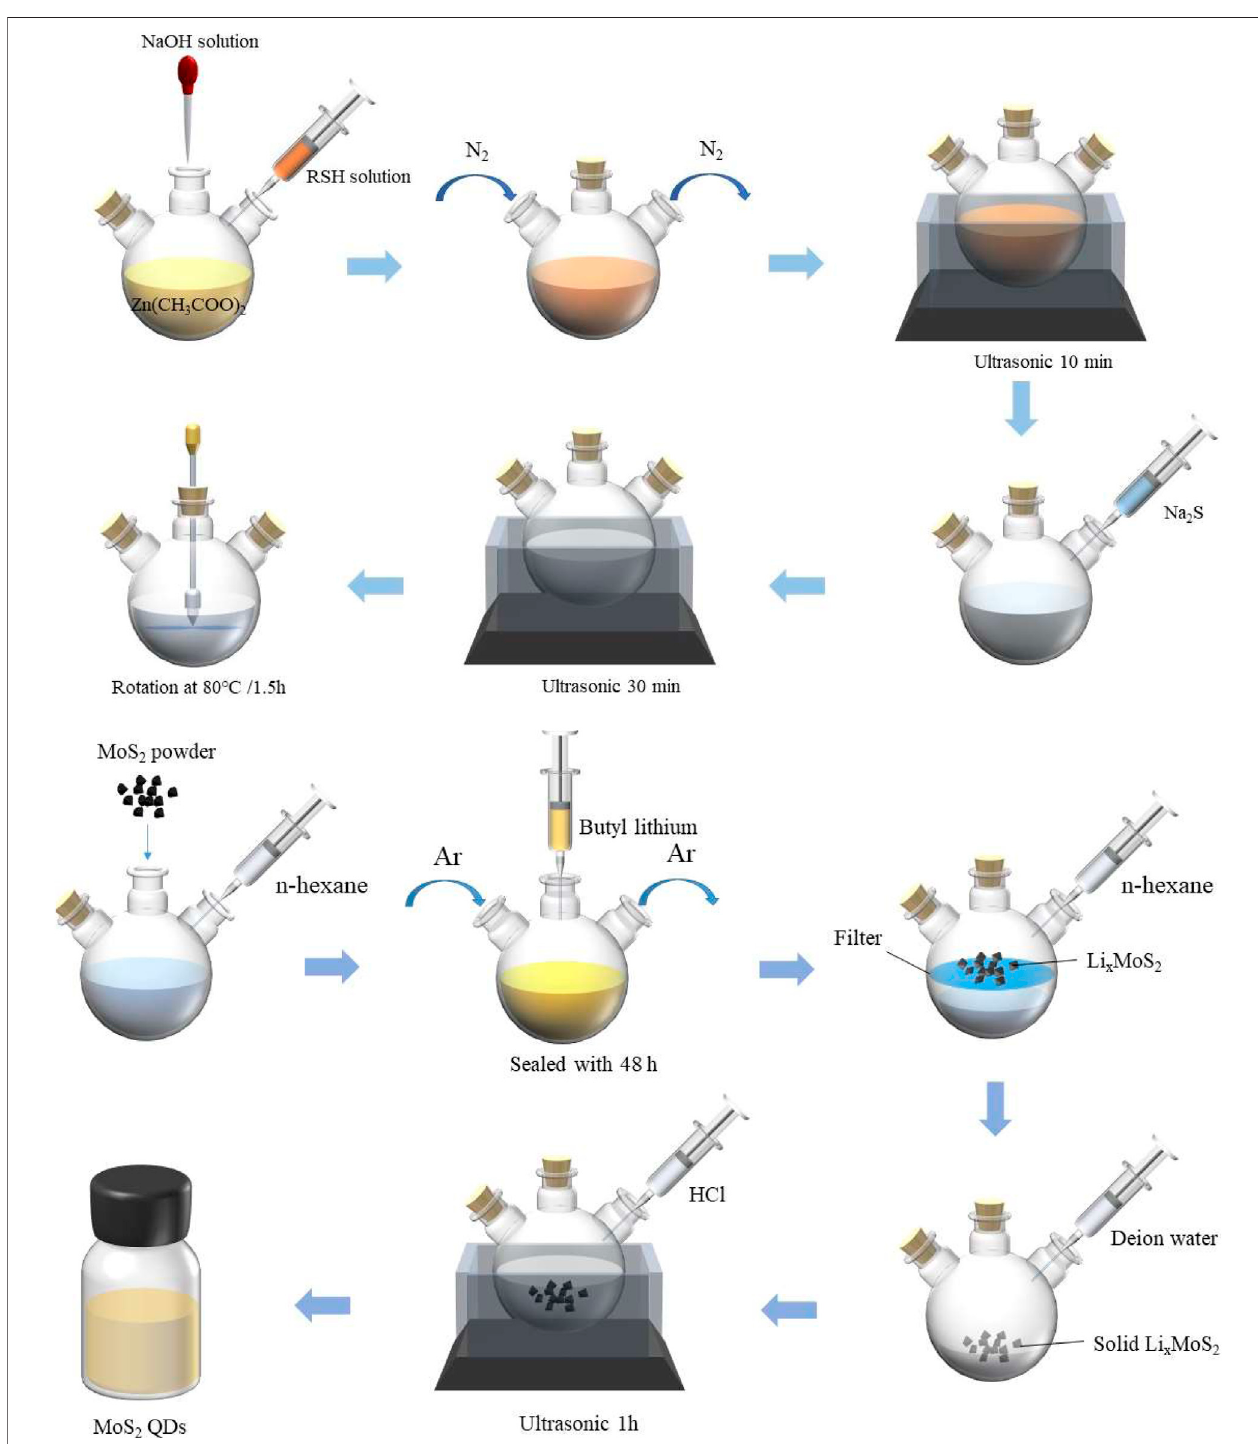
FIGURE 1 | Schematic of ZnS QDs (upper) and MoS 2 QD (below) synthesis procedure.